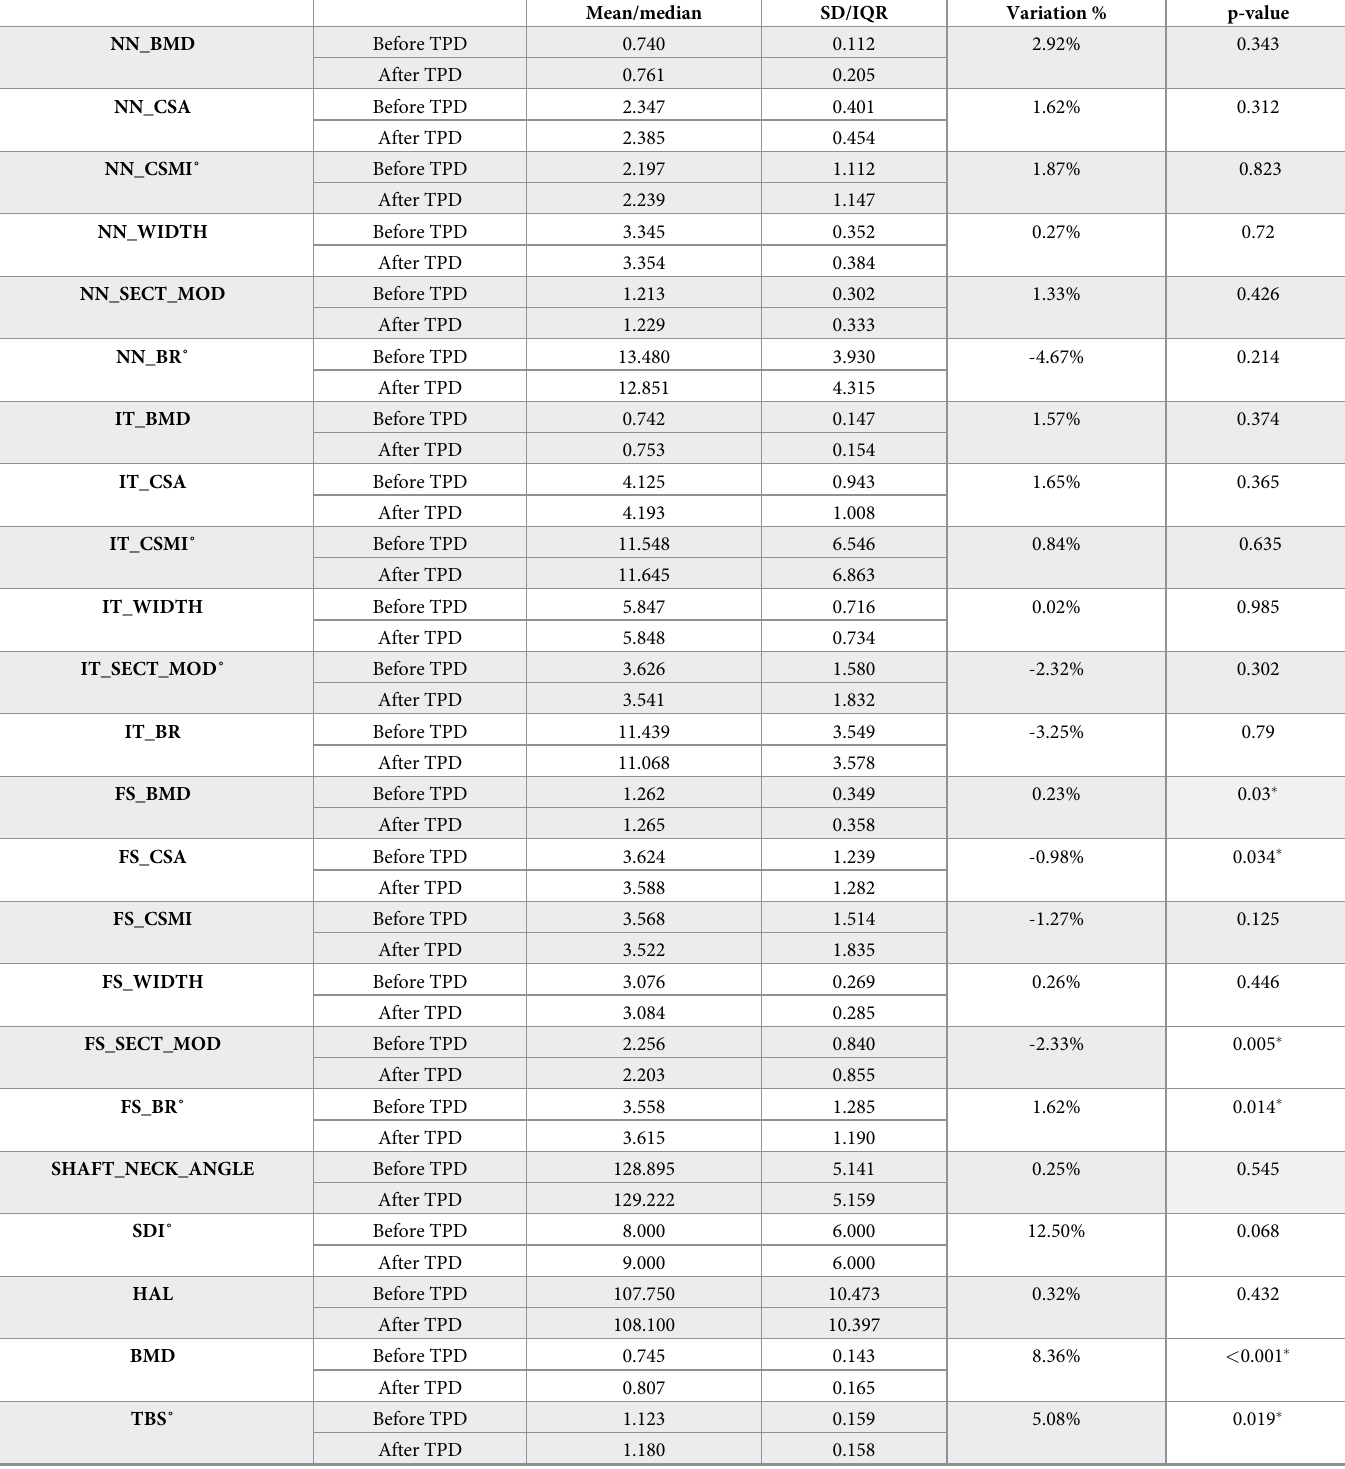
Table 1. SDI and DXA parameters of the entire population (40 patients) before and after TPD